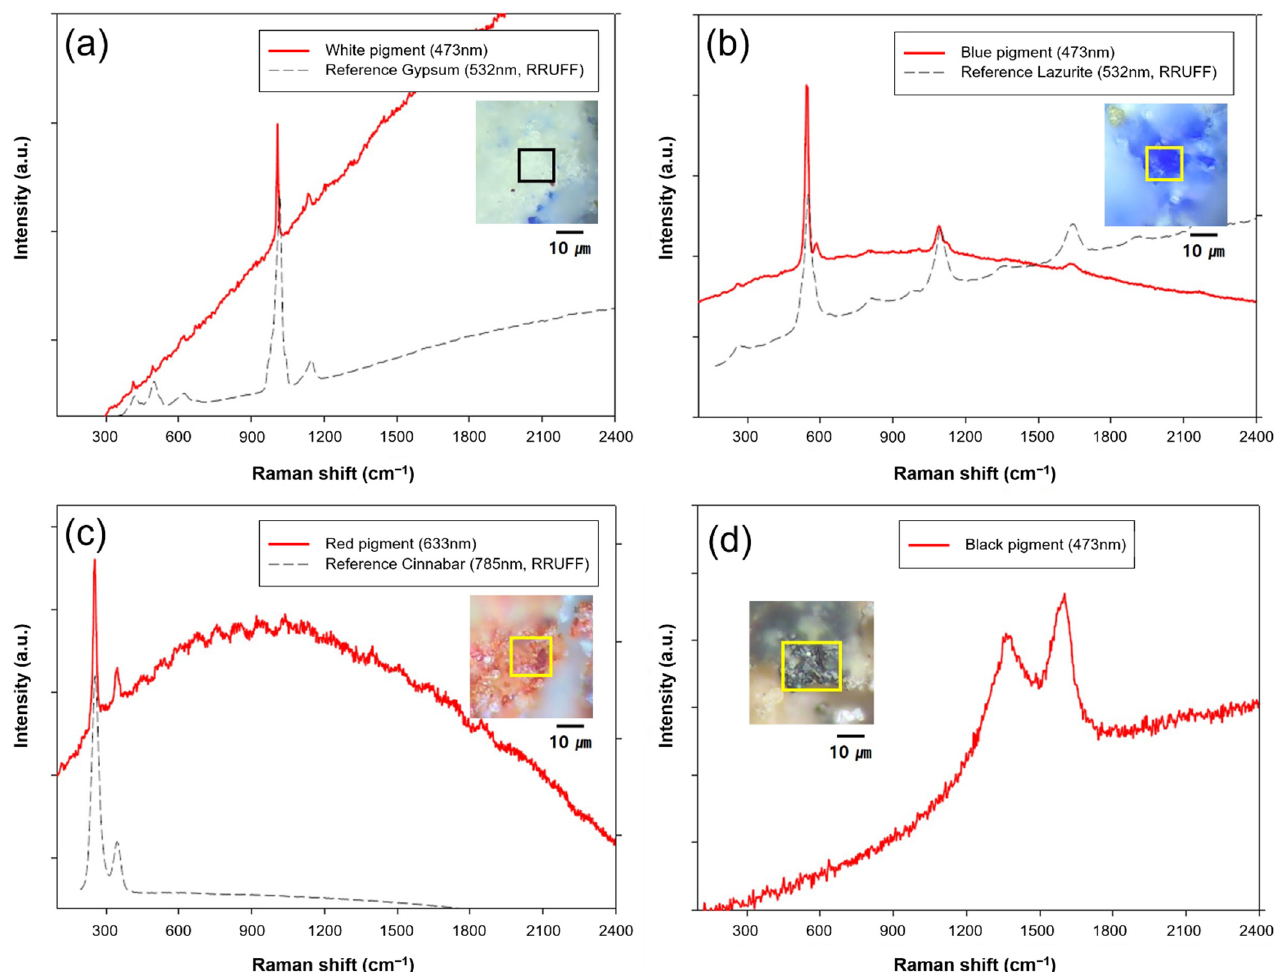
Figure 6. Raman spectra and target particles of ( a ) white background, ( b ) blue pigment, ( c ) red pigment, and ( d ) black pigment.